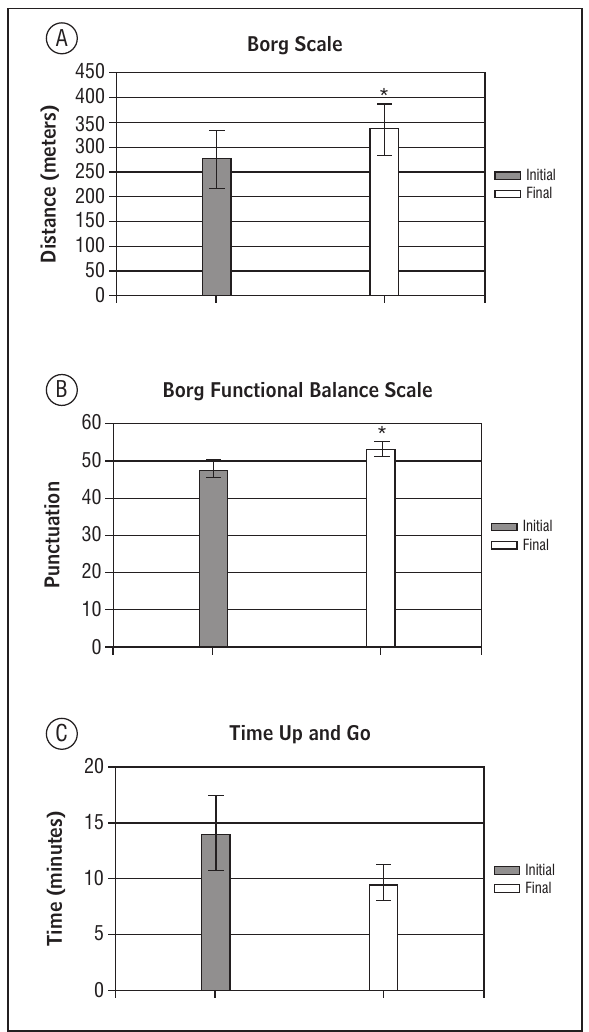
Figure 1 - Borg Scale, Berg Functional Balance Scale and Time Up and GO